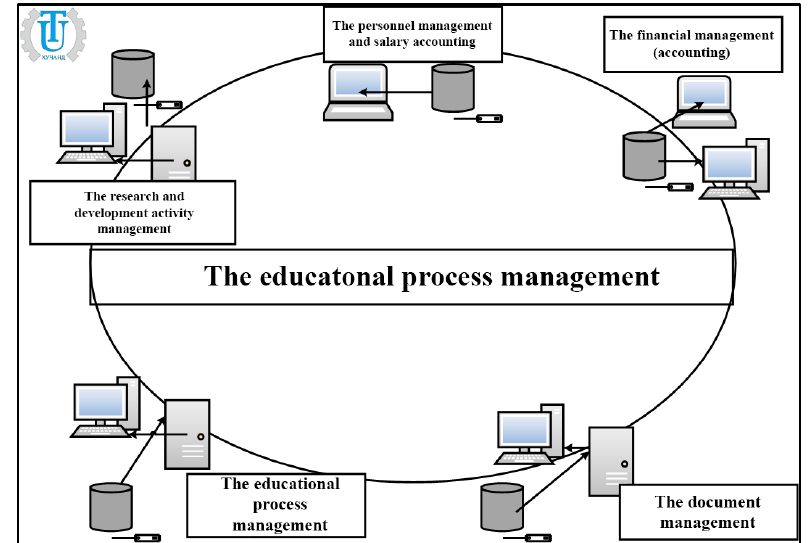
Fig. 4. Structure of interaction between KPITTU MIS